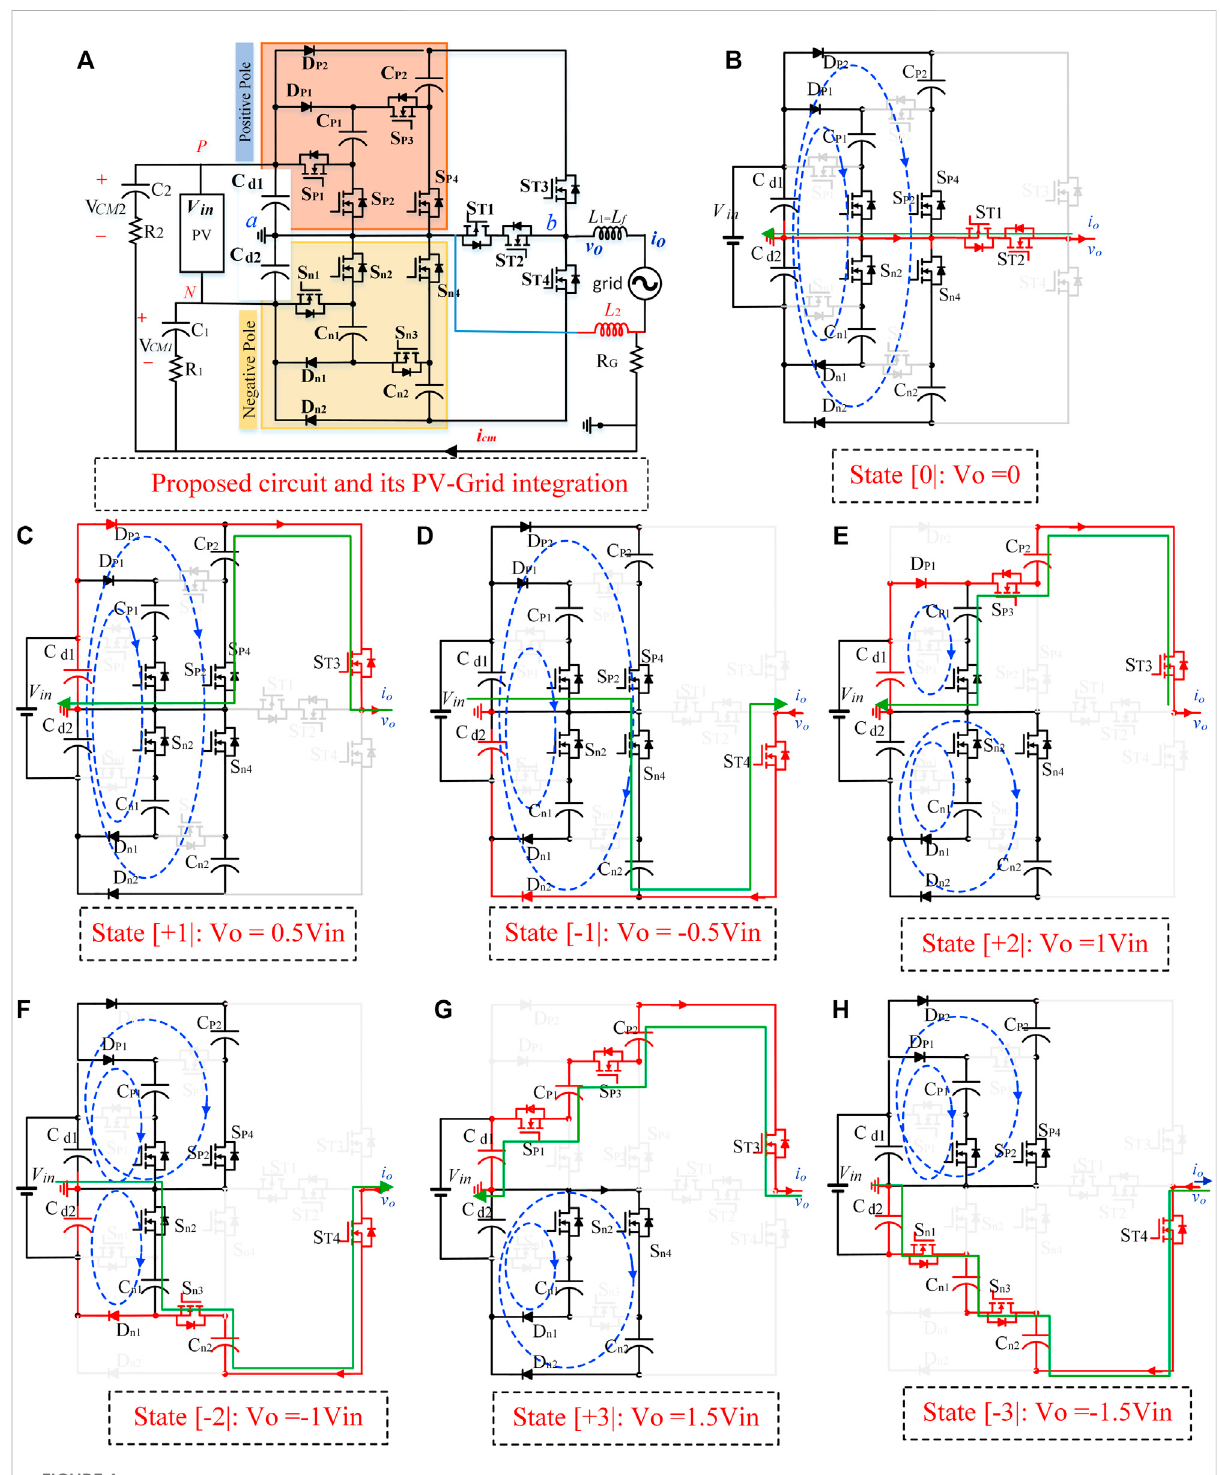
FIGURE 1 Circuit con fi guration, photovoltaic grid integration, and modes of operation of the proposed